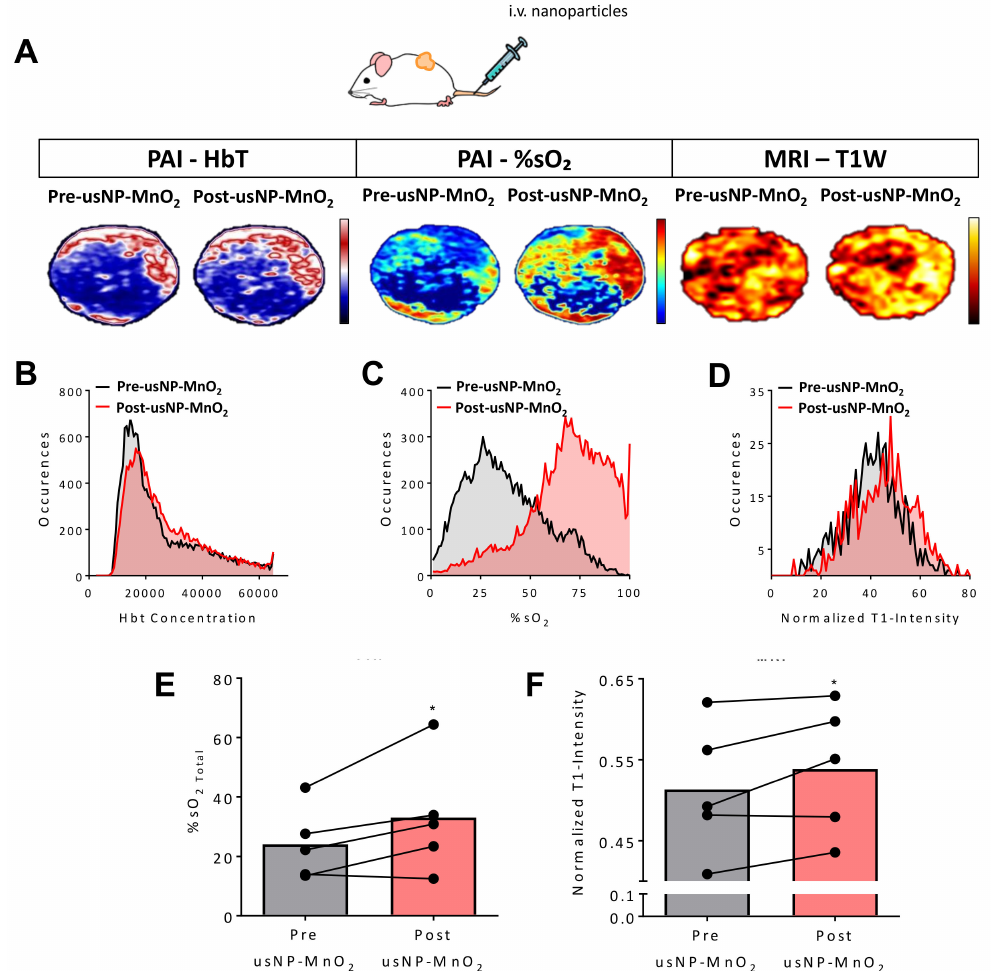
Figure 4. Modulation of hypoxia in head and neck squamous cell carcinomas (HNSCC) xenografts following systemic delivery of H 2 O 2 responsive usNP-MnO 2 . ( A ) The panel of images represent co-registered Hbt (left), %sO 2 (middle) and normalized T1-intensity maps (right) of an HNSCC patient-derived xenograft (PDX) before and after intravenous (i.v.) administration of H 2 O 2 responsive usNP-MnO 2 . Corresponding histograms of hemoglobin concentration (Hbt; B ), %sO 2 ( C ), and T1-intensity ( D ) before and following usNP-MnO 2 nanoparticle injection are shown. Graphs show increases in tumor %sO 2 ( E ) and normalized T1W intensity ( F ) following nanoparticle injection, * indicates p <